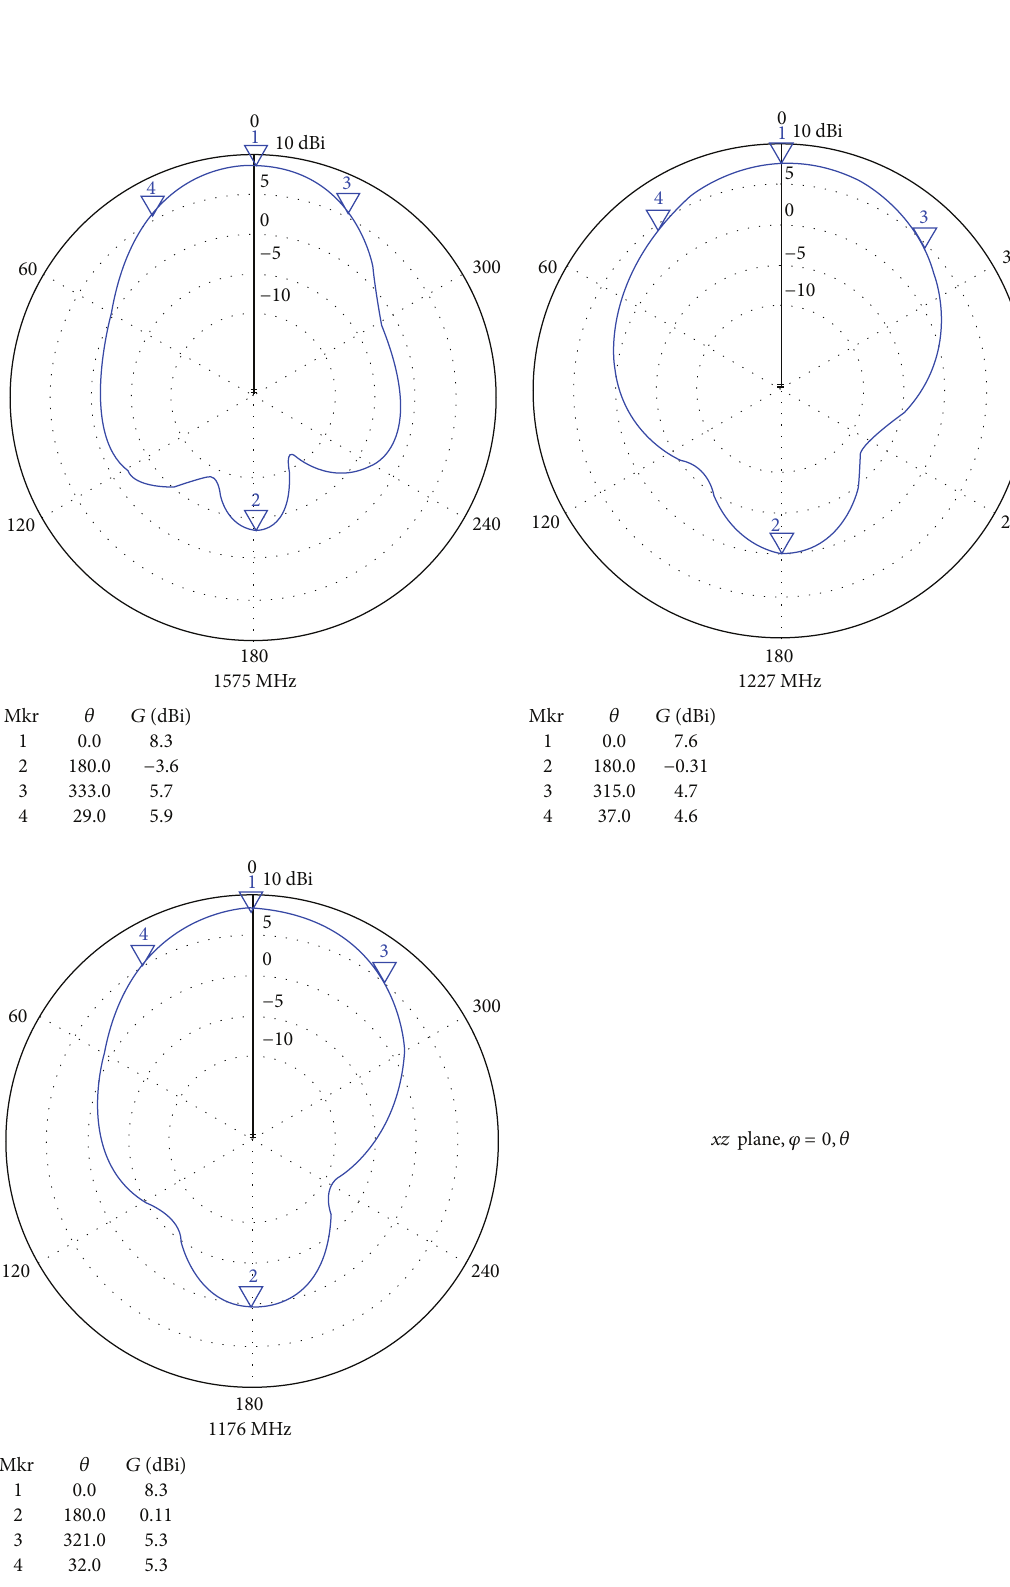
Figure 8: Radiation patterns at 𝑥𝑧 plane for the modified PIFA at 1575 MHz, 1227 MHz, and